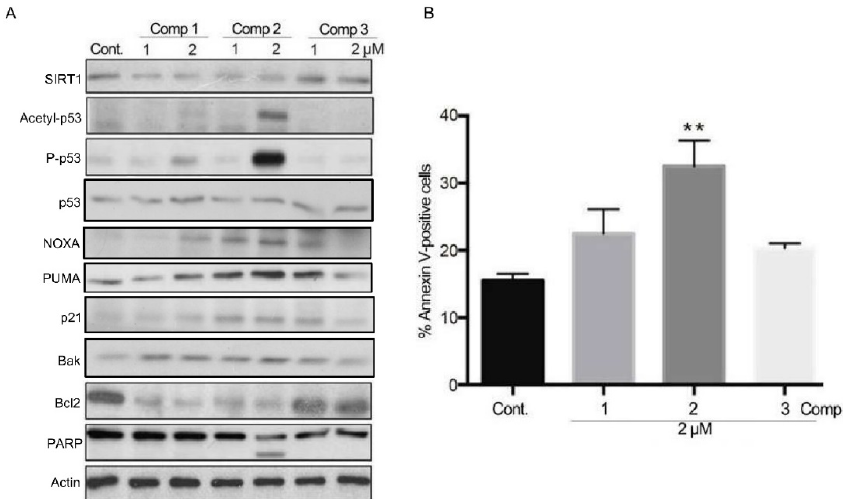
Figure 4. The effects of the selected derivatives on protein expression and apoptosis in HepG2 cells. ( A ) HepG2 cells were treated with different concentrations of compounds or vehicle for 24 h, and cell lysates were separated by SDS-PAGE and analyzed by western blotting. β -Actin was used as an internal control. Representative images are shown. ( B ) Cells were treated with different derivatives for 24 h, and the percentage of apoptotic cells was determined by flow cytometry. The presented values (mean ± SEs) represent as the percentage of cells in early and late apoptotic populations at least three independent experiments (** p < 0.01 for treated cells vs. controls). Representative images are shown.